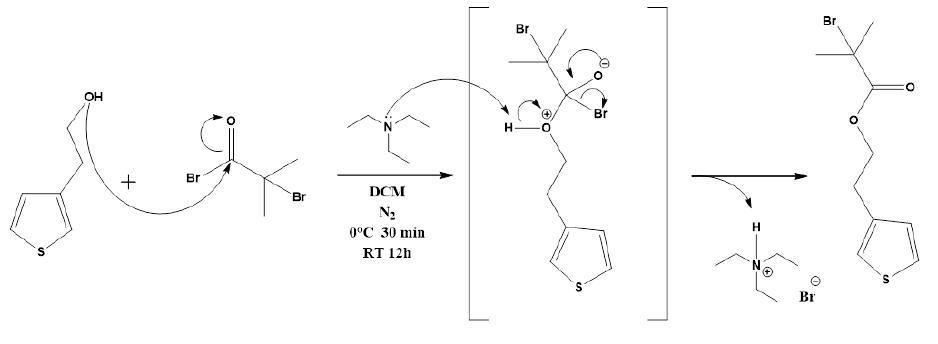
Figure 1. Reaction mechanism of ThBr synthesis.